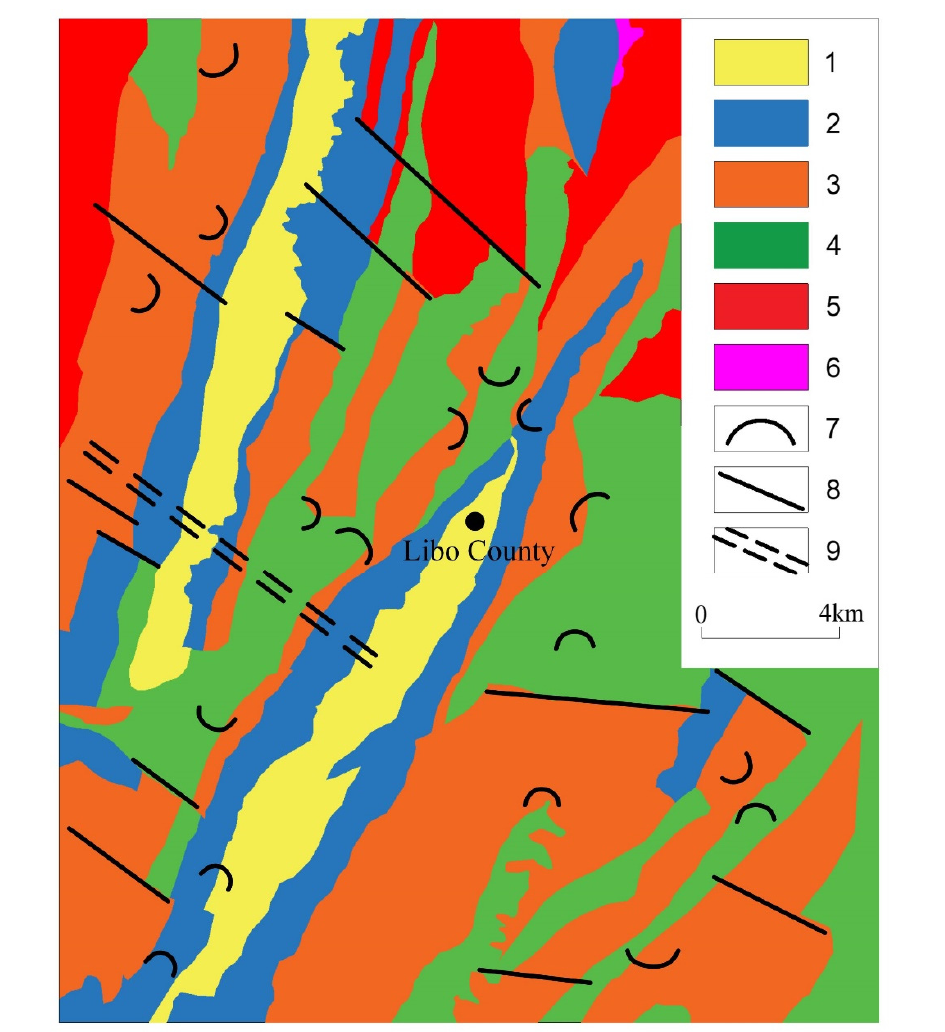
Figure 5. Geological map of Libo County (recreated based on [39]).